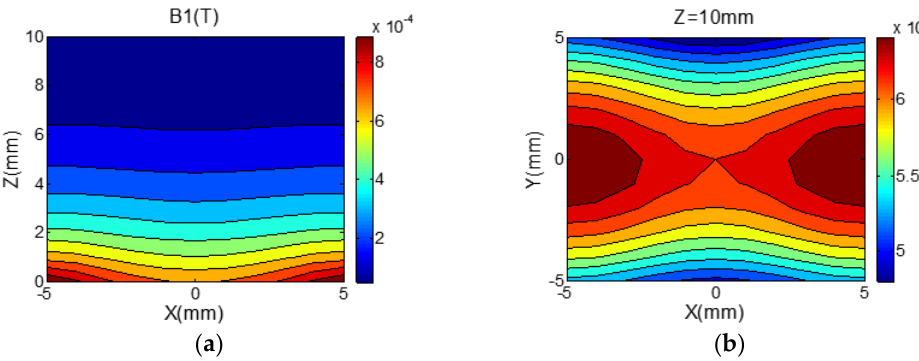
Figure 7. ( a ) Measured 𝐵 1 strength in ROI on transverse sections. ( b ) Measured 𝐵 1 strength in ROI on longitudinal sections.